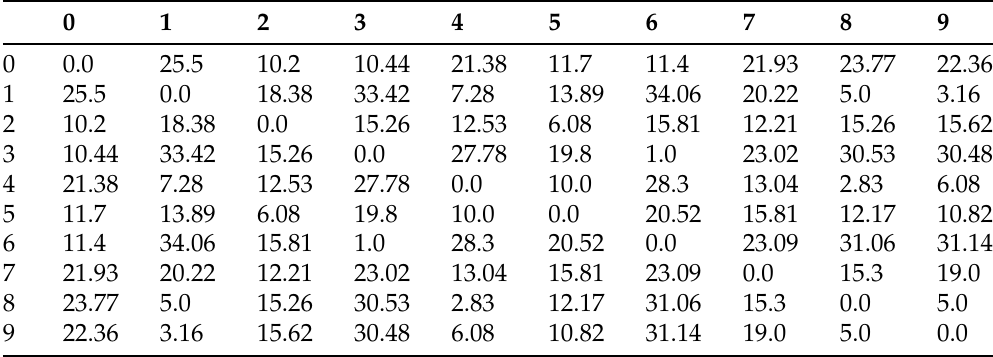
Table 7. The matrix of the distances between devices, which was used by the LP model to generate the activation